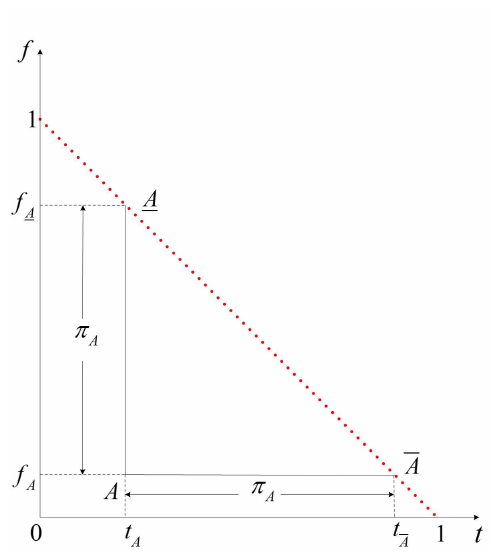
Figure 1. The upper and lower determinations of the IFV A